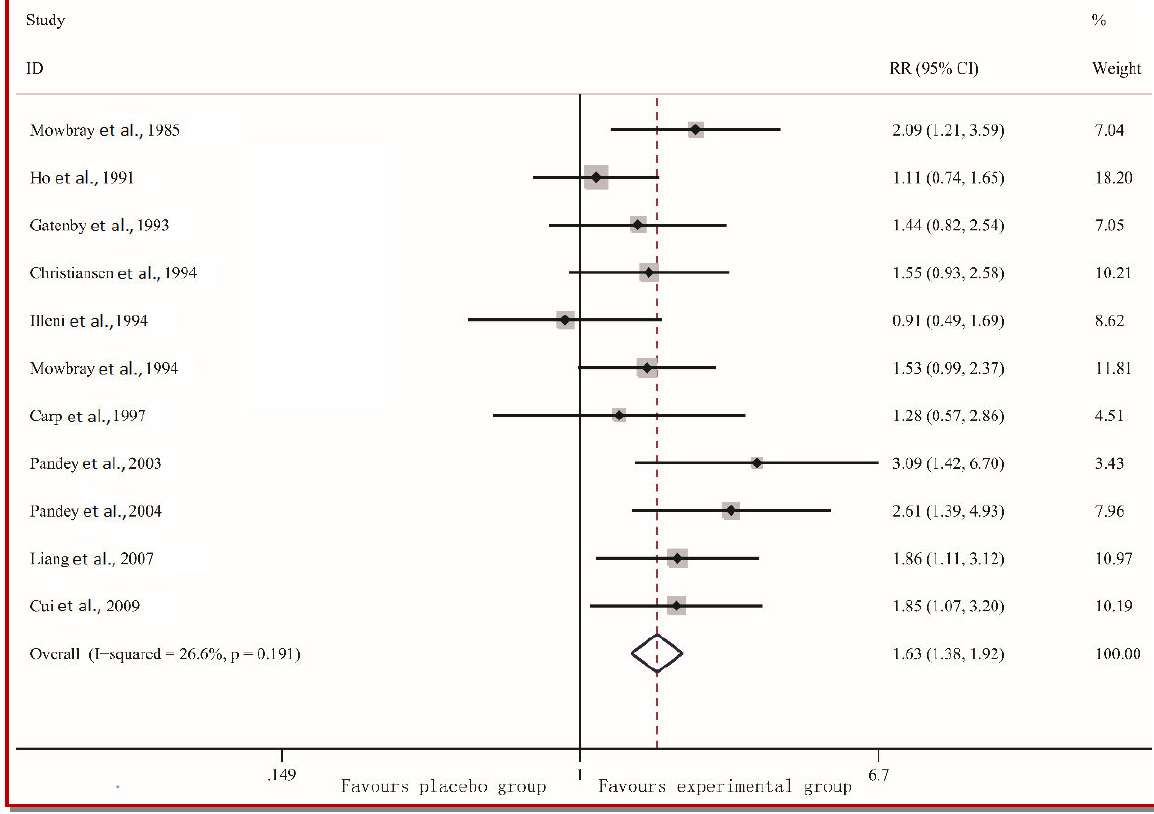
Figure 3: Live birth rate comparison between paternal or third-party lymphocyte and